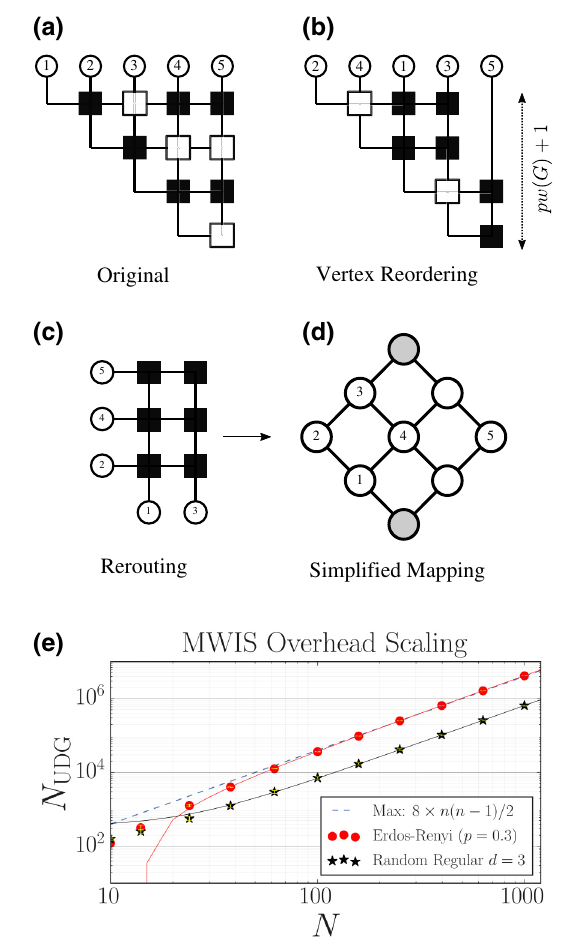
FIG. 10. (a)–(c) Simplification techniques to reduce the over- head. Vertex reordering can be used to reduce the depth of the crossing lattice. (d) Final mapping of the K 2,3 graph after biparti- tion and vertex reordering, reducing the overhead mapping from 92 nodes to 9 [see Fig. 6(b)]. (e) MWIS overhead scaling as a function of the number of vertices of original randomly